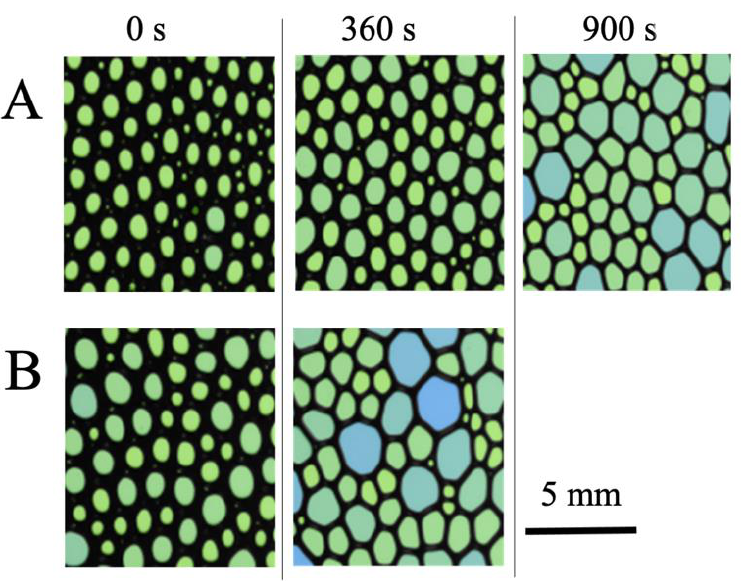
Figure 7. Macroscopic images at elapsed times of 0, 360, and 900 s obtained for foams of ( A ) C 12 –EtOH– β Ala and ( B ) C 12 –Me– β Ala surfactants, which were attached to the glass wall of the dynamic foam analyzer.